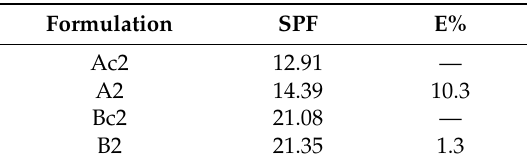
Table 5. In vitro sun protection factor (SPF) values of formulations containing only organic UV-filters (Ac2 and Bc2) or organic UV-filters and vegetable oils (A2 and B2) and the percentage of SPF enhancement (E%) of the formulation containing organic UV-filters and vegetable oils in comparison to the same formulation without vegetable oils.